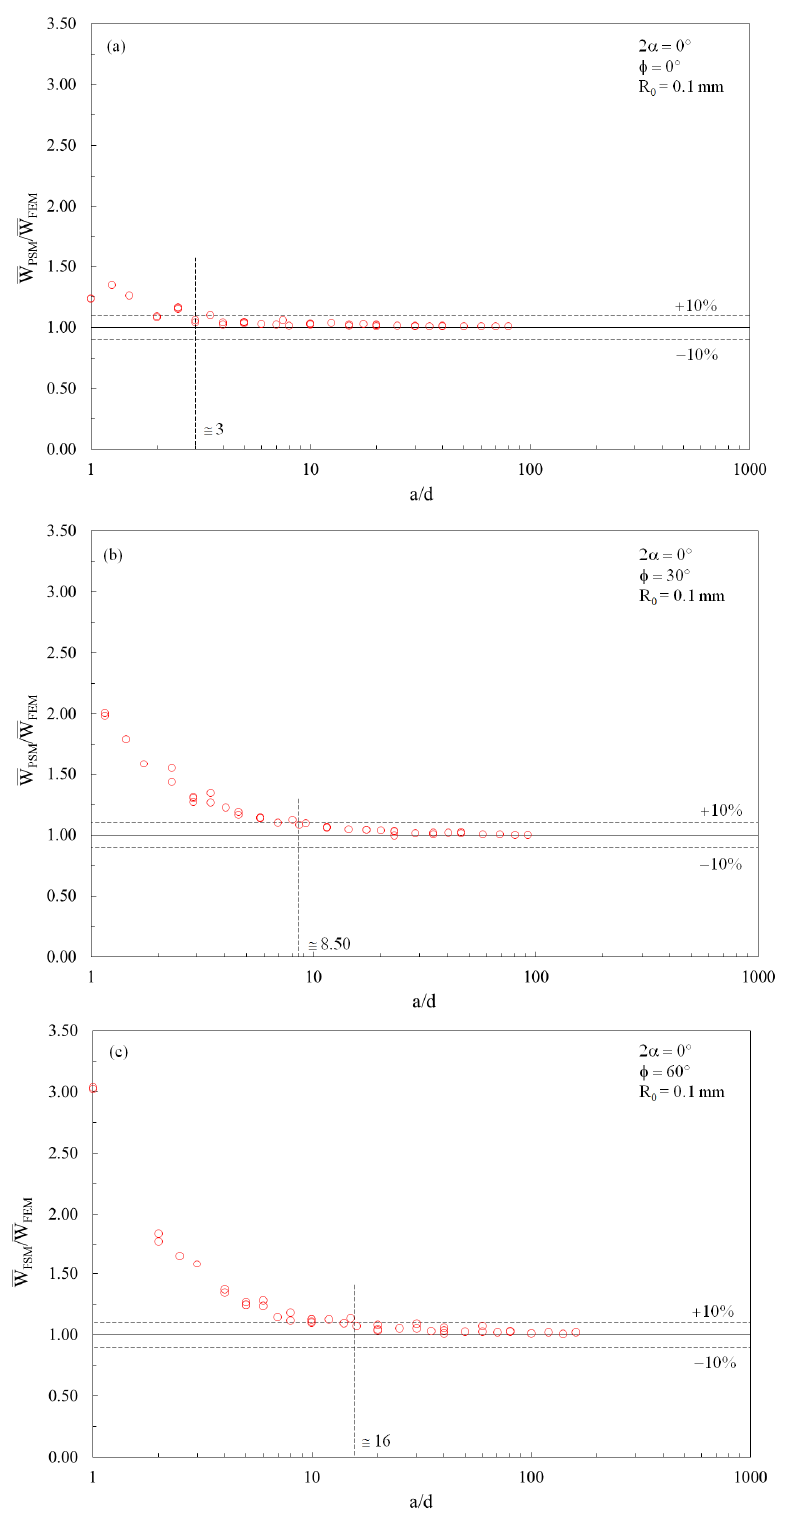
Figure 5: Ratio between the SED based on the elastic peak stresses (W PSM ) and the SED derived from the FE analyses (W FE ) for a crack (2 α = 0°) under mixed mode (I+II) loading: (a) ϕ = 0° (MM = 0), (b) ϕ = 30° (MM = 0.37) and (c) ϕ = 60° (MM =